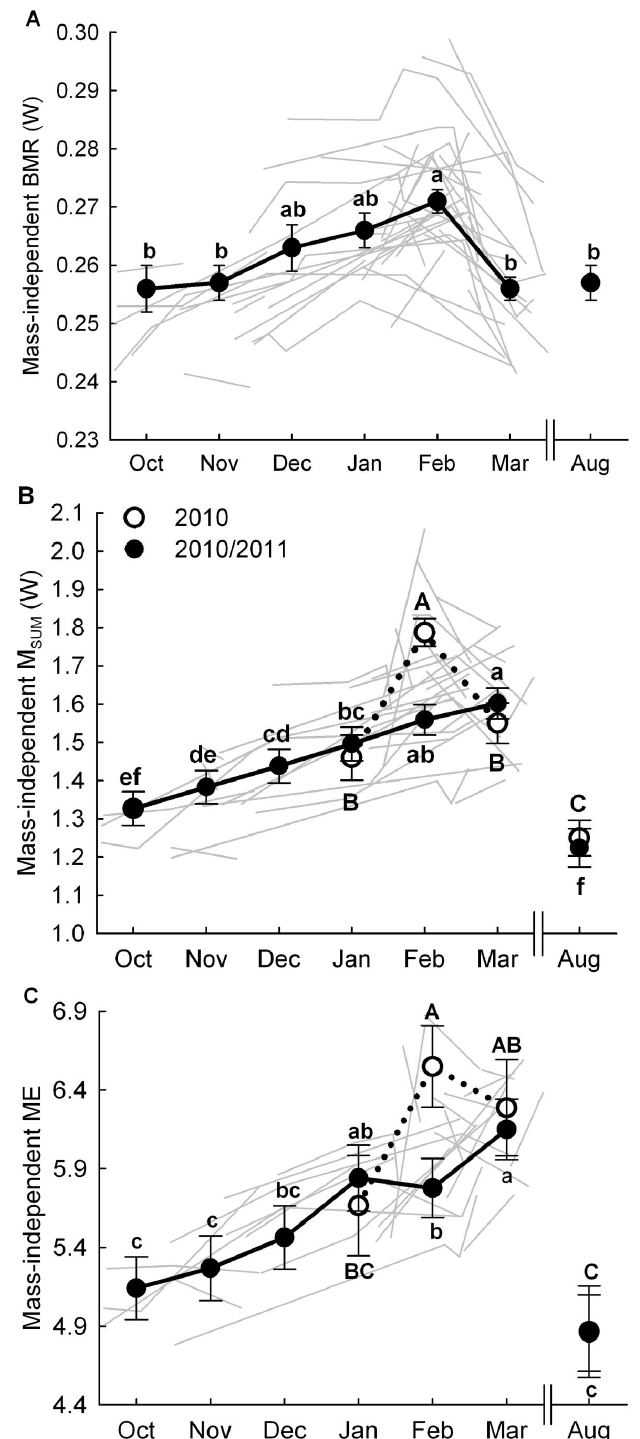
Figure 3. Monthly variation at the population and individual levels in mass-independent BMR, M and ME. Population data SUM (black line and dots) are least square means for BMR (A), M (B) and ME (C) controlling for year, month, sex, body mass and bird SUM ID as random parameter. In B and C - dotted line, open dots and uppercase: 1 st year; solid line, black dots and lowercase: 2 nd year. Different letters represent significant difference between months within a year. Predicted values calculated from LMEs (see text for details) are used to visualize data from individuals captured more than once (grey lines). doi: 10.1371/journal.pone.0068292.g003 PLOS ONE |